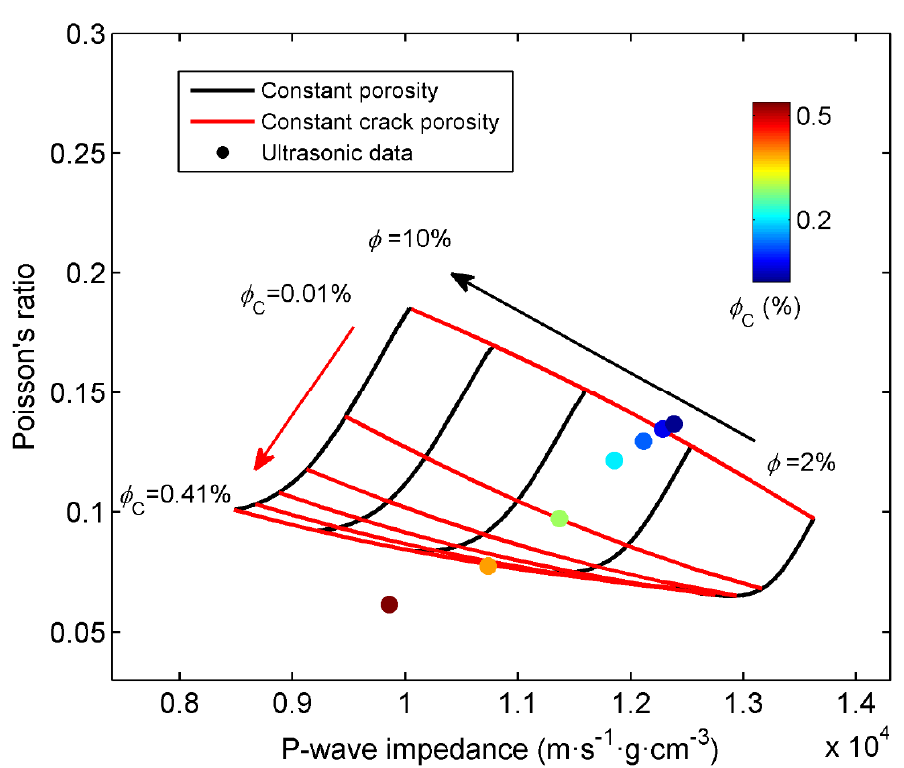
Figure 13. Ultrasonic data and corresponding RPT. The color bar indicates the microcrack poros-